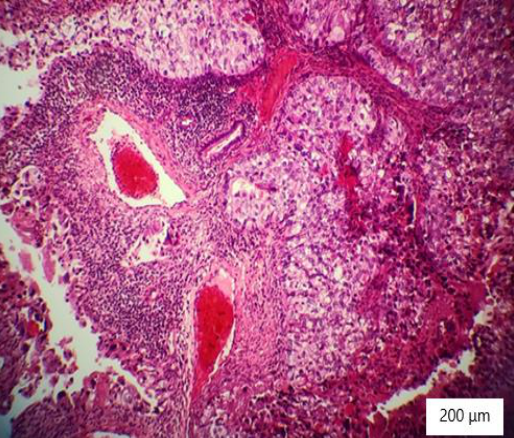
Figure 2. Solid architecture of the tumor with highly atypical cells with hyperchromatic nuclei and necrosis (HE ×100).